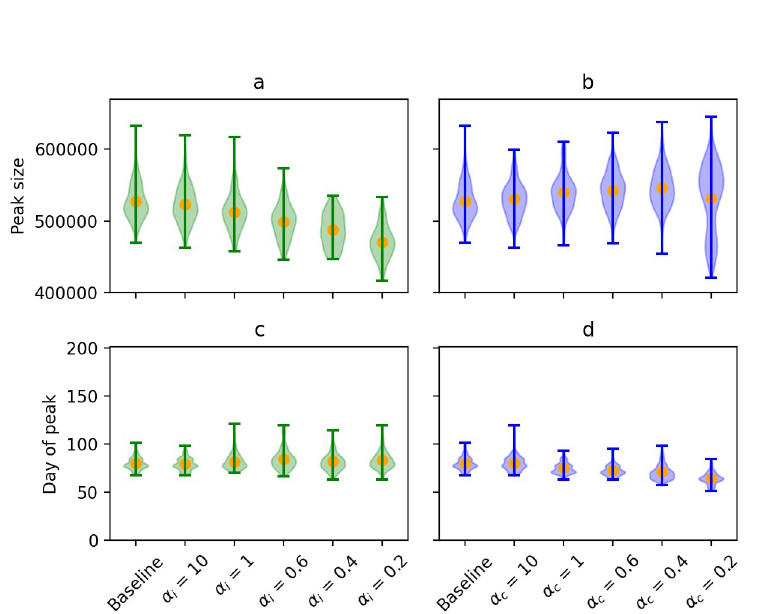
Fig 4. Violin plots for the size and day of peak across the different simulation runs for scenarios investigating the infectiousness-related heterogeneity (in green, panels a and c, respectively) and contact-related heterogeneity (in blue, panels b and d, respectively). The orange dots represent the mean of the simulated peak sizes and days at which the peak is reached. Simulation runs in which extinction occurs ( < 20 cases) were excluded.